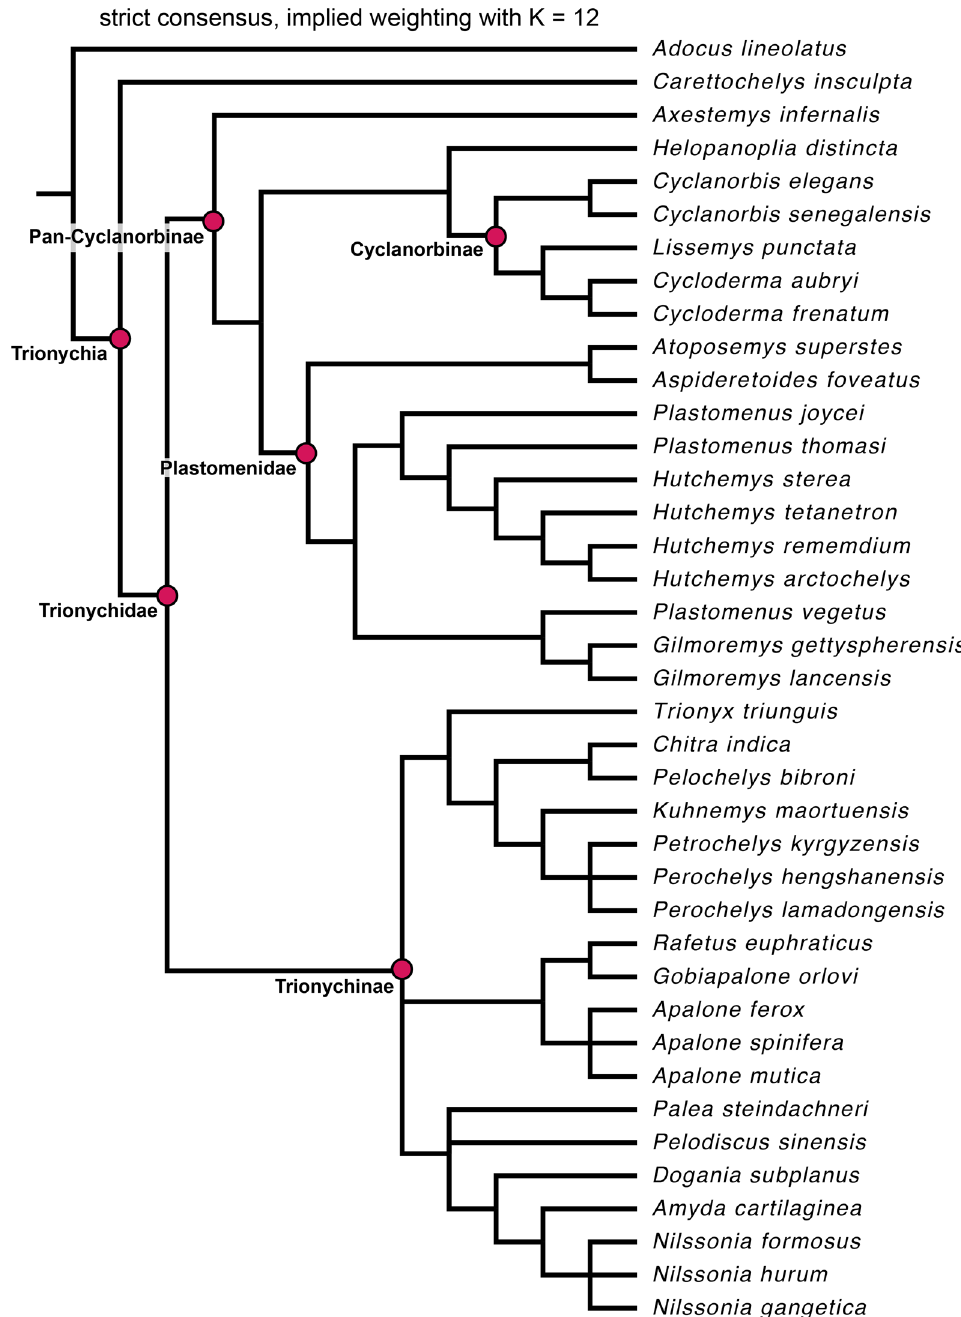
Fig. 13 Phylogenetic results from parsimony analysis using implied weights with a concavity constant of K